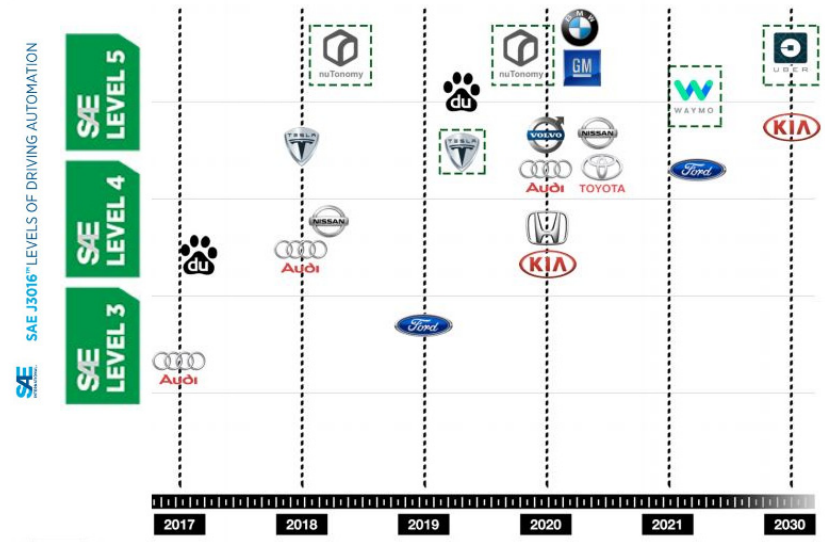
Figure 2. Evolution and expectations about automotive companies AVs market [10].